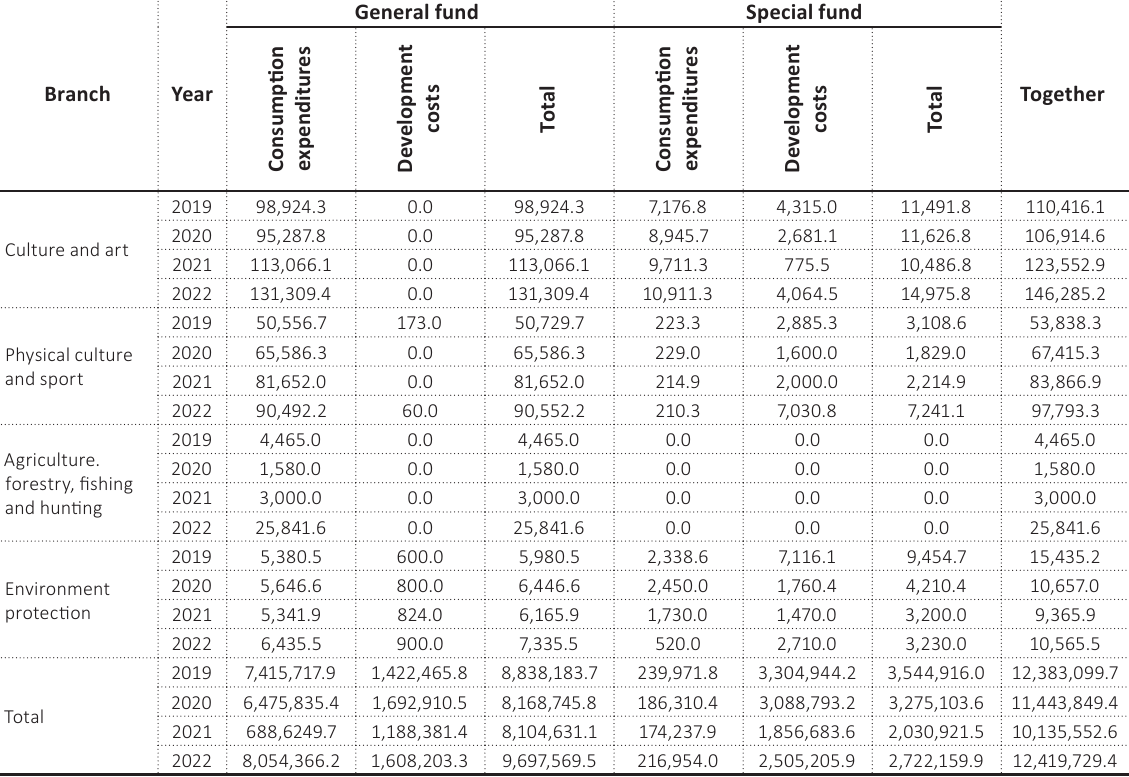
Table A4. Recreation-relevant branches regarding the distribution of expenditures in the budget of the city of Odessa, thousand UAH, 2019–2021